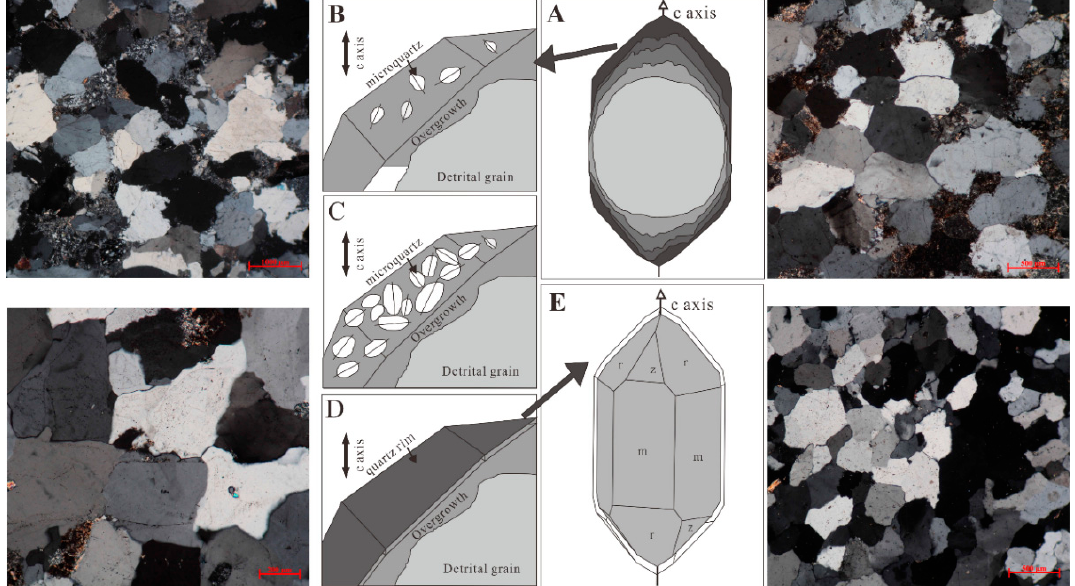
Figure 5. The second stage of quartz overgrowth: the process of coaxial growth; ( A ) the recovery of the rounding quartz grain to hexagonal dipyramid; ( B ) growth of micro-quartz on the surface of hexagonal dipyramid grain; ( C ) a large number of micro-quartz developed on the surface; ( D ) the new layer formed by micro-quartz; ( E ) the whole quartz after coaxial growth.